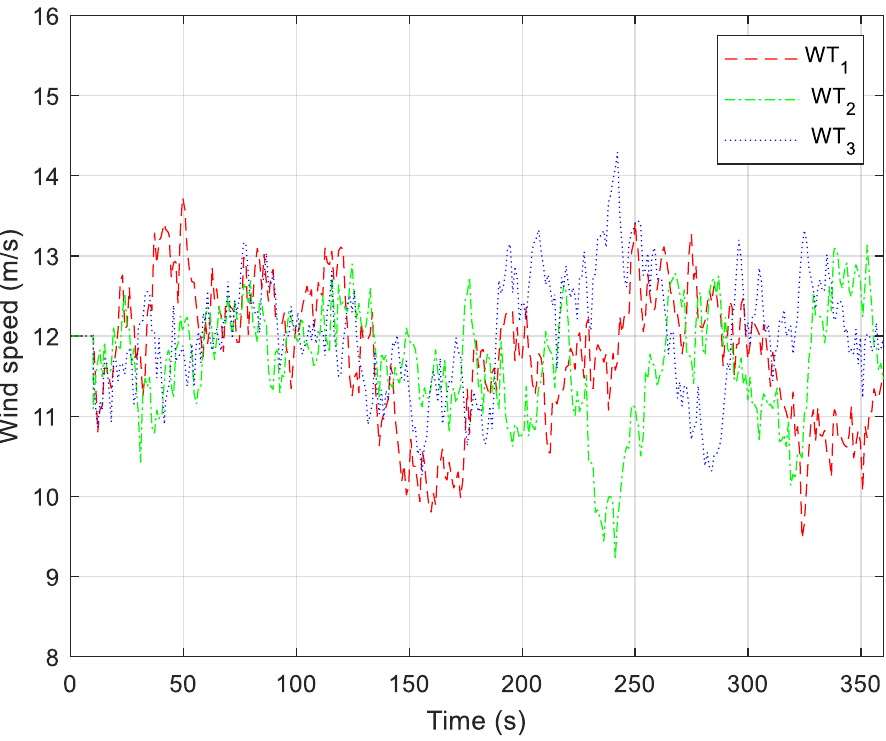
Figure 20. Random wind disturbance applied to the wind park.